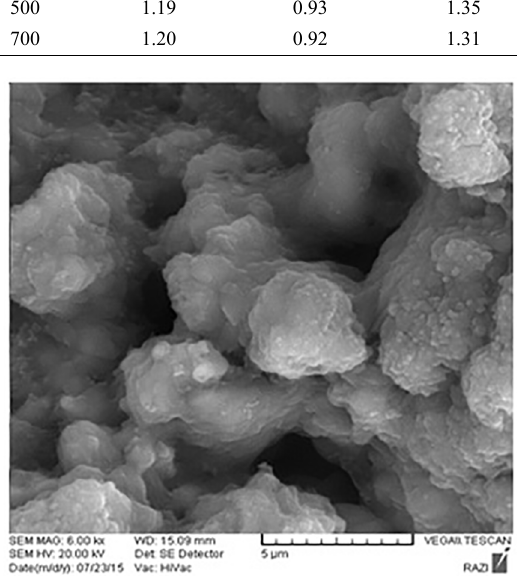
Figure 6. SEM image of pressed sample under pressure of 300 MPa